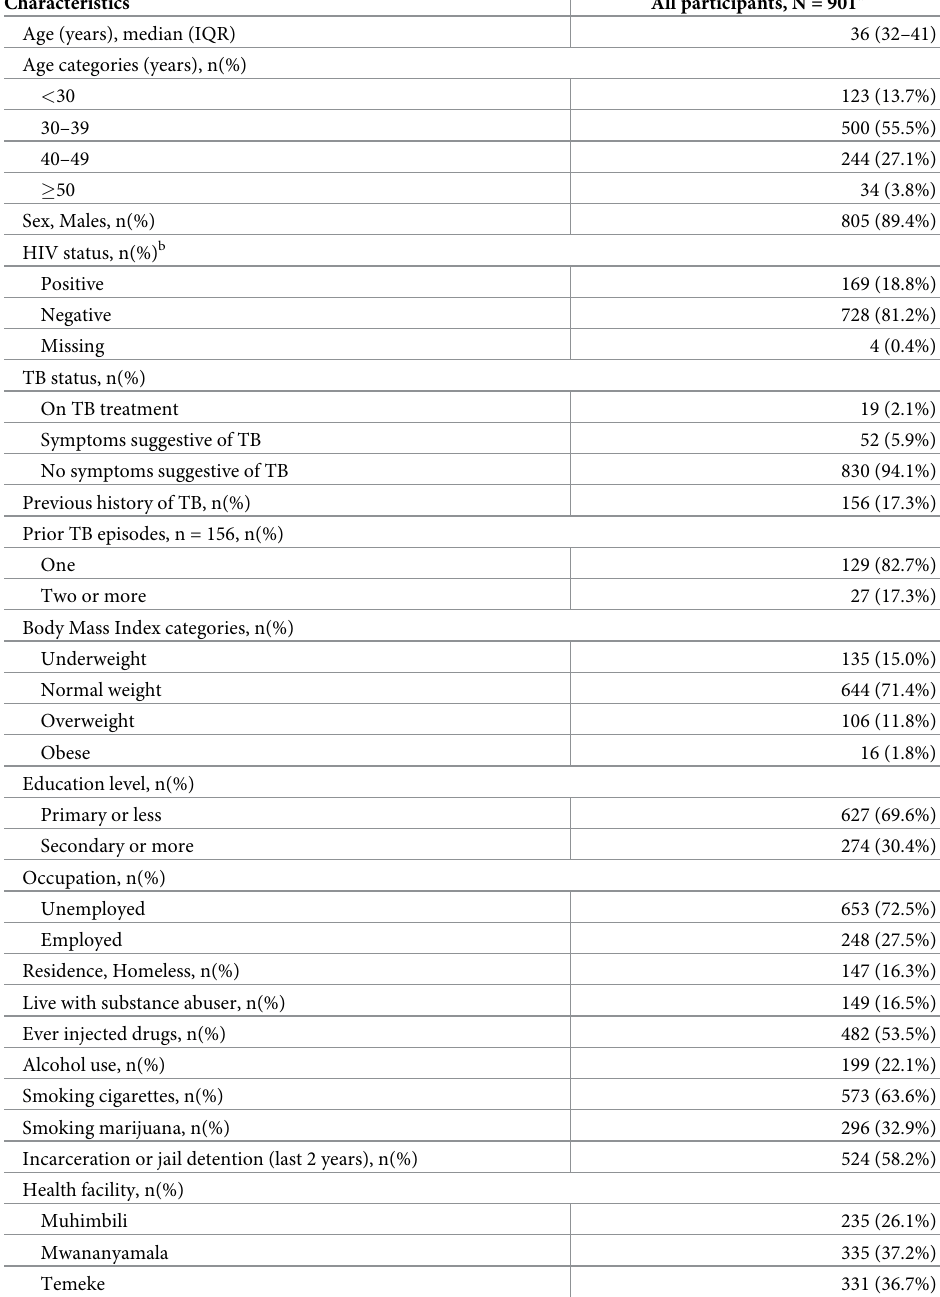
Table 1. Baseline socio-demographic and clinical characteristics among people receiving medication-assisted treatment for substance use disorder in Dar es Salaam, Tanzania (N = 901).